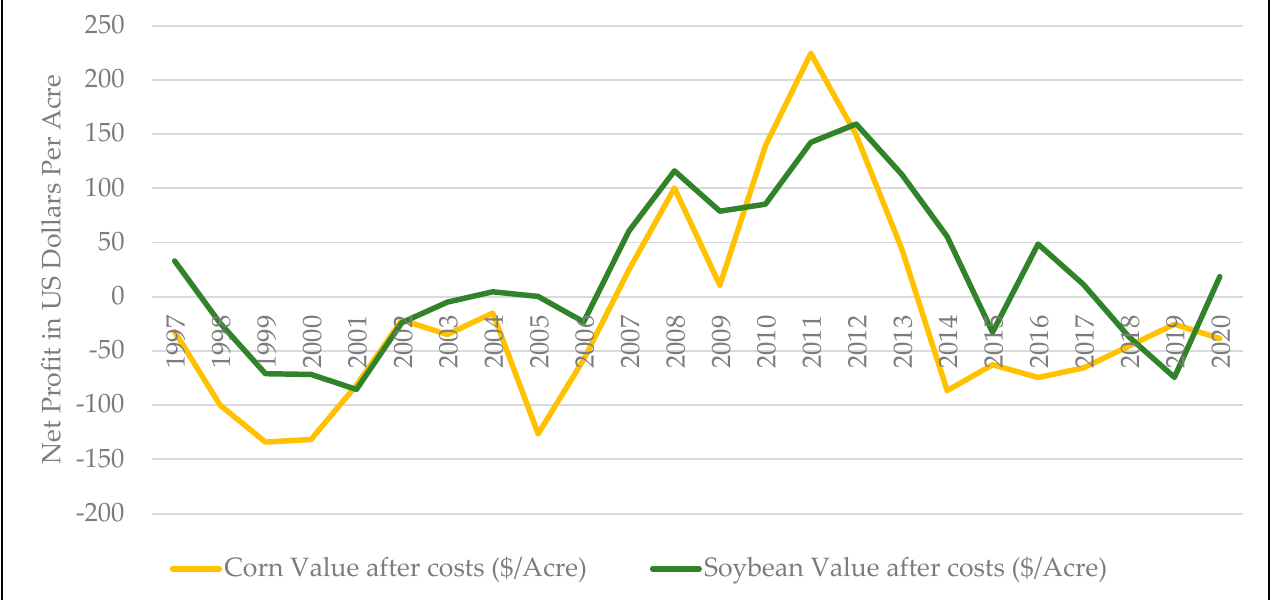
Figure 13. Net value of soybean and corn ($/Acre).